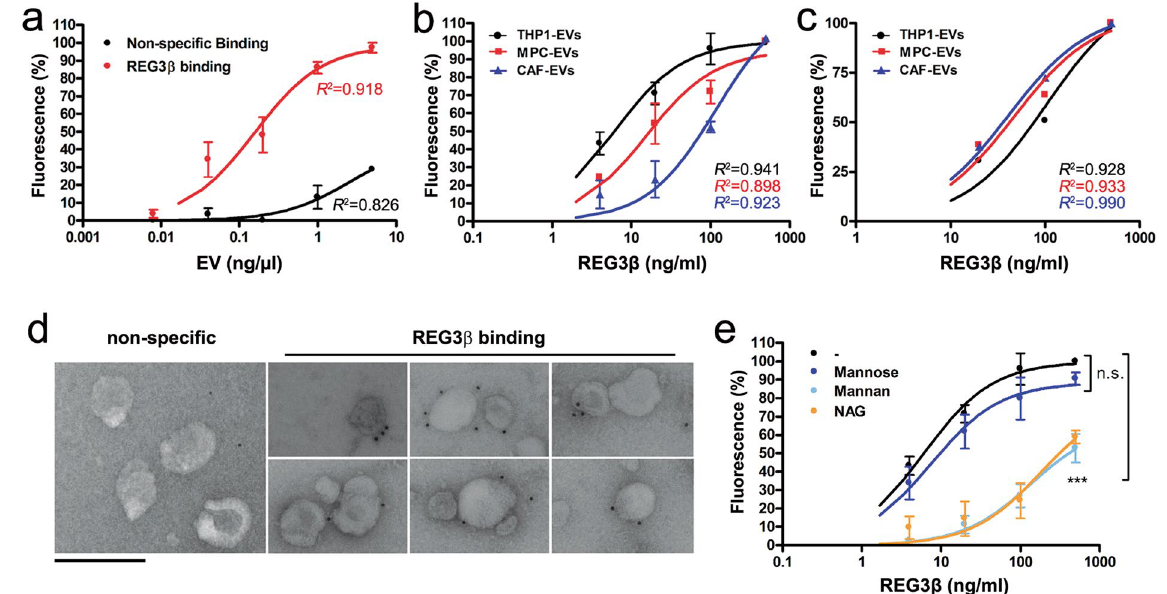
Figure 2. REG3 β interacts with EVs through its lectin domain. ( a ) PKH26-labeled THP1-EVs binding to plates coated with anti-REG3 β antibody and saturated with 500 ng/ml of REG3 β . The indicated concentrations of EVs were used. Non-specific binding was assessed in the absence of REG3 β . Data are depicted as relative expression to saturation (5 ng/ µ l of EV) (n = 4). ( b , c ) PKH26-labeled EVs (1 ng/ µ l of EV protein) binding to plates ( b ) or magnetic beads ( c ) coated with anti-REG3 β antibody and incubated with the indicated concentrations of REG3 β . Data are depicted as relative expression to maximum binding (500 ng/ml of REG3 β ). ( d ) Anti-REG3 β immunogold labeling of THP1-EVs incubated with REG3 β (500 ng/ml). Non-specific binding was tested in the absence of REG3 β . Scale bar: 200 nm. ( e ) Competitive assay of PKH26-labeled THP1-EVs binding to REG3 β as in (B), but in the presence of 1 mg/ml mannose, 1 mg/ml mannan or 5 mM of NAG. (n = 4). *** P < 0.001 compared to non-sugar binding (F test). In all panels, data are expressed as mean ± SEM. R 2 represents goodness of fit to the one-site binding hyperbola